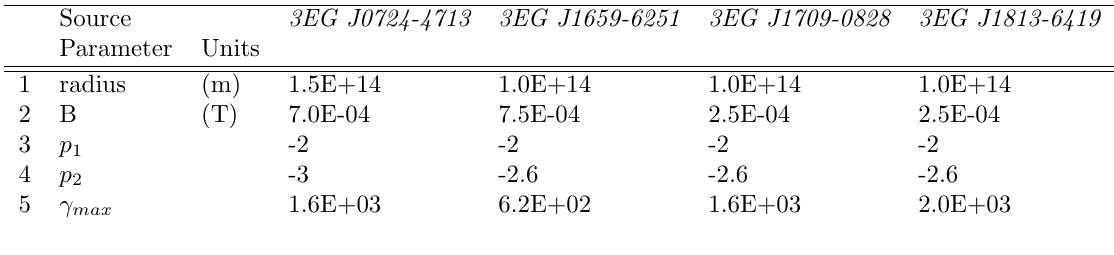
Table 1: Parameters related to SSC models for the respective sources.